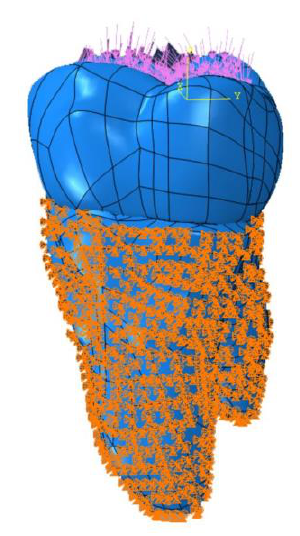
Figure 1. Load and boundary conditions.